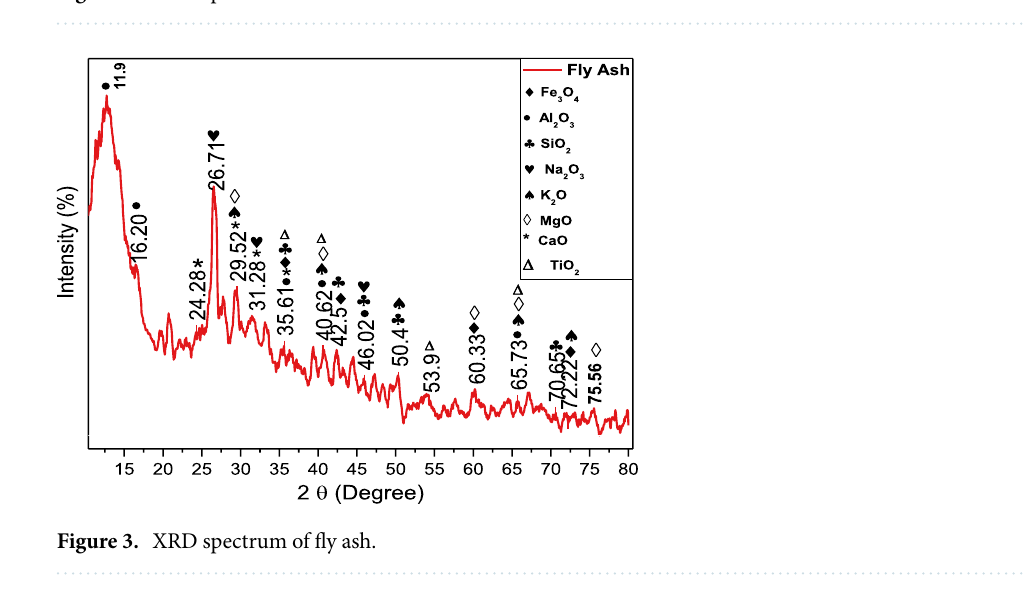
Figure 2. XRD spectrum of rice straw biochar.